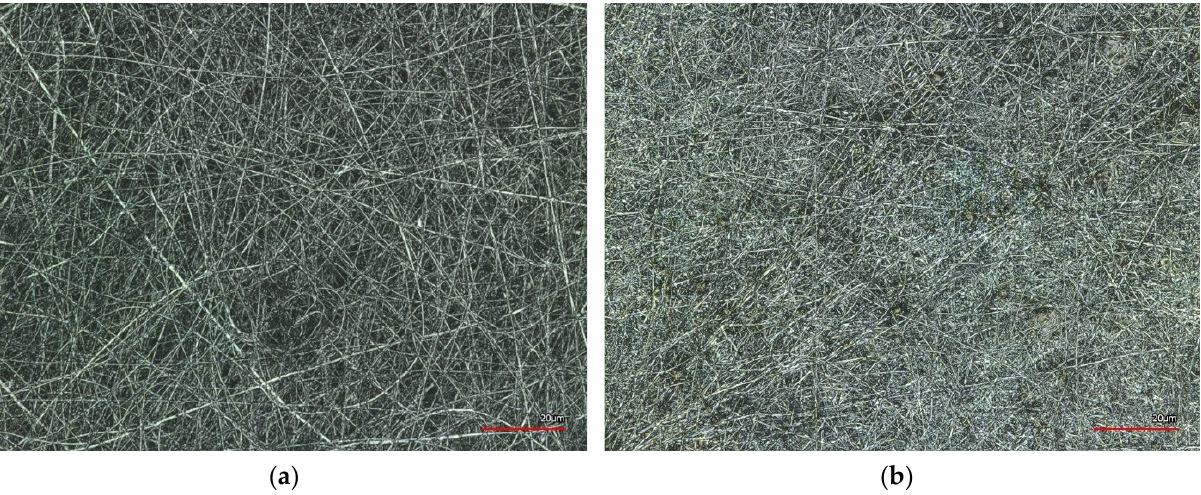
Figure 2. Confocal laser scanning microscope (CLSM) images showing a nanofiber mat with biopolymer lignin (10 wt% PEO and 1 wt% lignin) ( a ) and a nanofiber mat with PAN/magnetite (10 wt% PAN and 5 wt% Fe 3 O 4 ( b ). Scale bars indicate 20 µm.